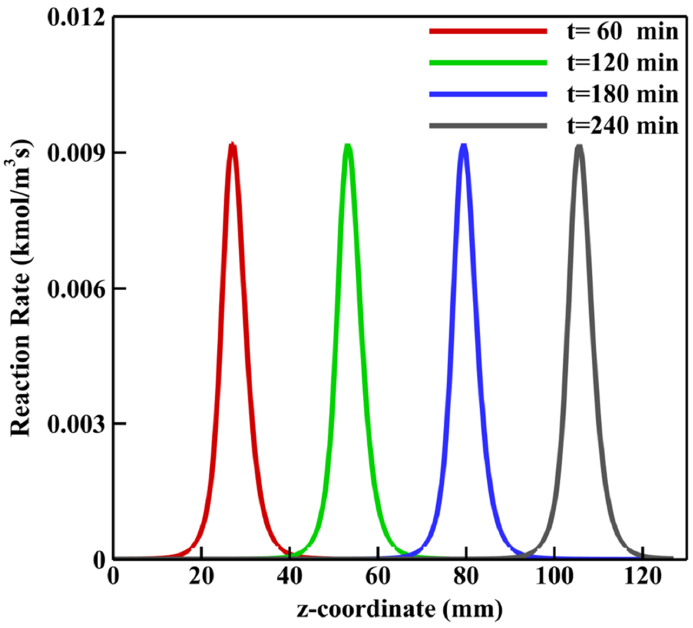
Figure 3. The rate of reaction between zeolite and water along the reactor axis.